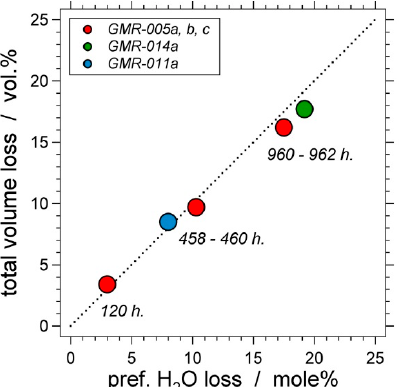
Figure 17. Preferential H 2 O loss (in the amount of substance fraction, also known as mole%) versus total volume loss of the fluid inclusion (in vol%) (after Bakker and Doppler [12]). The run-times of the experiments are illustrated with numbers (in hours), and the diagonal dashed line indicates an equal percentage of total volume loss and preferential H 2 O loss.